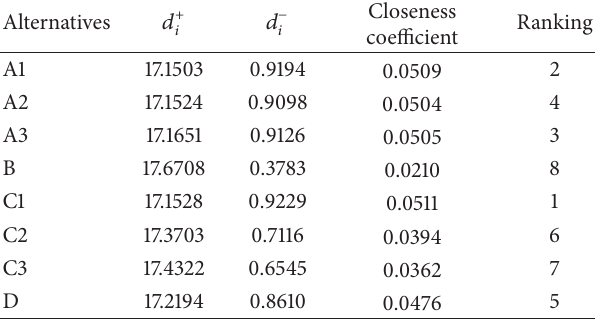
Table 5: Distances of each alternative from the fuzzy positive- and negative-ideal solution and closeness